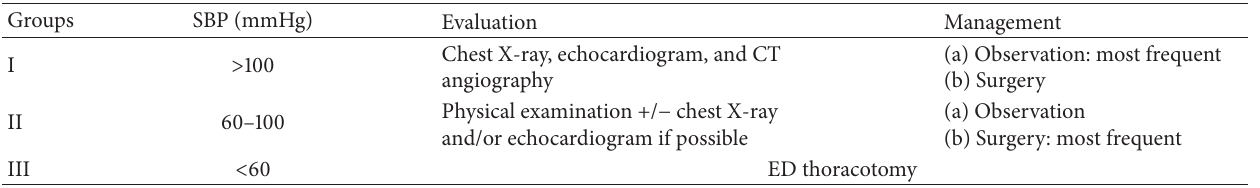
Table 1: Management of transmediastinal gunshot